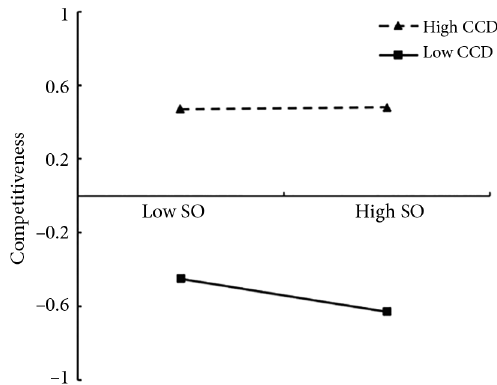
Figure 6. Moderating effect of the coupling degree on the relationship between SO and